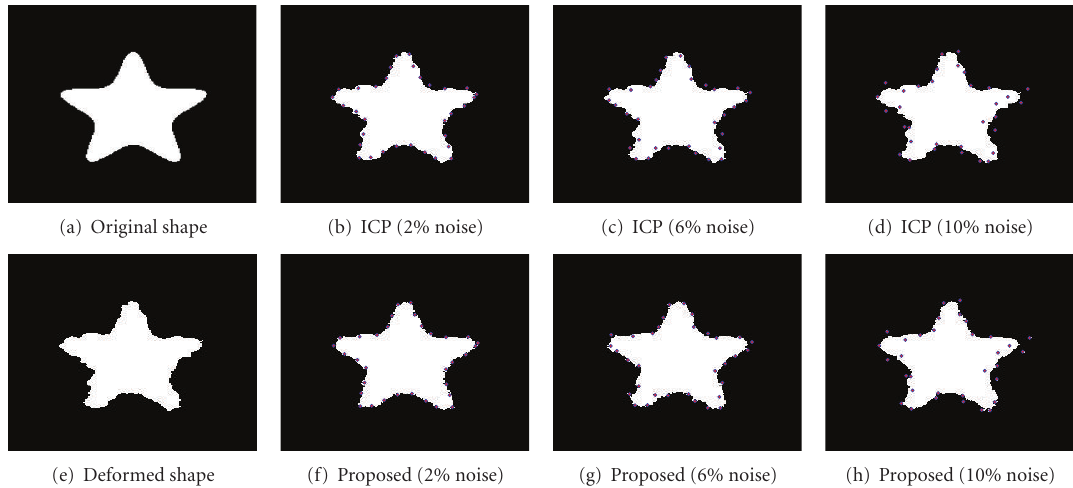
Figure 1: The shape reconstruction results for a synthetic 2D star shape, (a) the original shape, (b)–(d) ICP results using di ff erent Gaussian noise levels, (e) the deformed shape, and (f)–(h) results of the proposed method using di ff erent Gaussian noise levels.